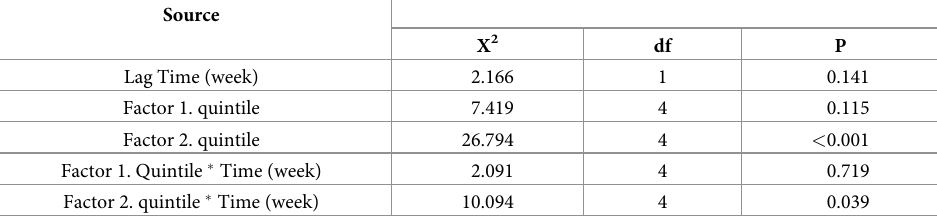
Table 2. The effect of the marginal model results in the independent and dependent